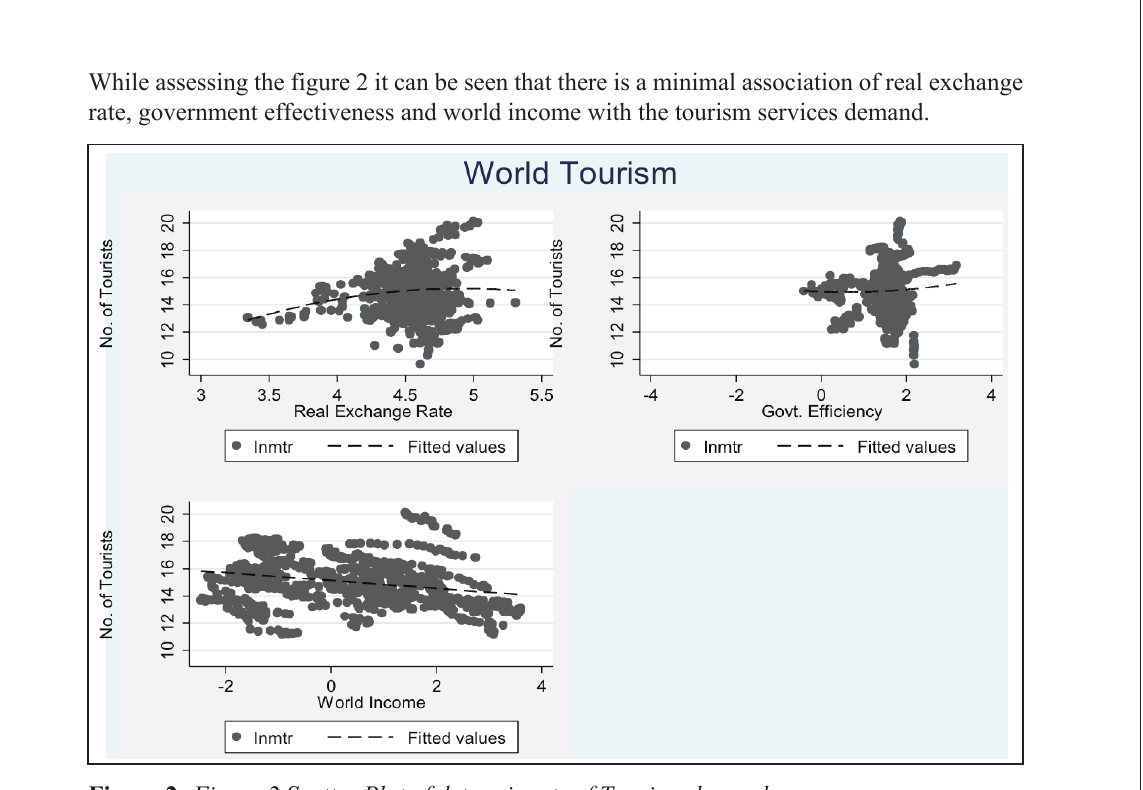
Figure 2: Figure 2 Scatter Plot of determinants of Tourism demand